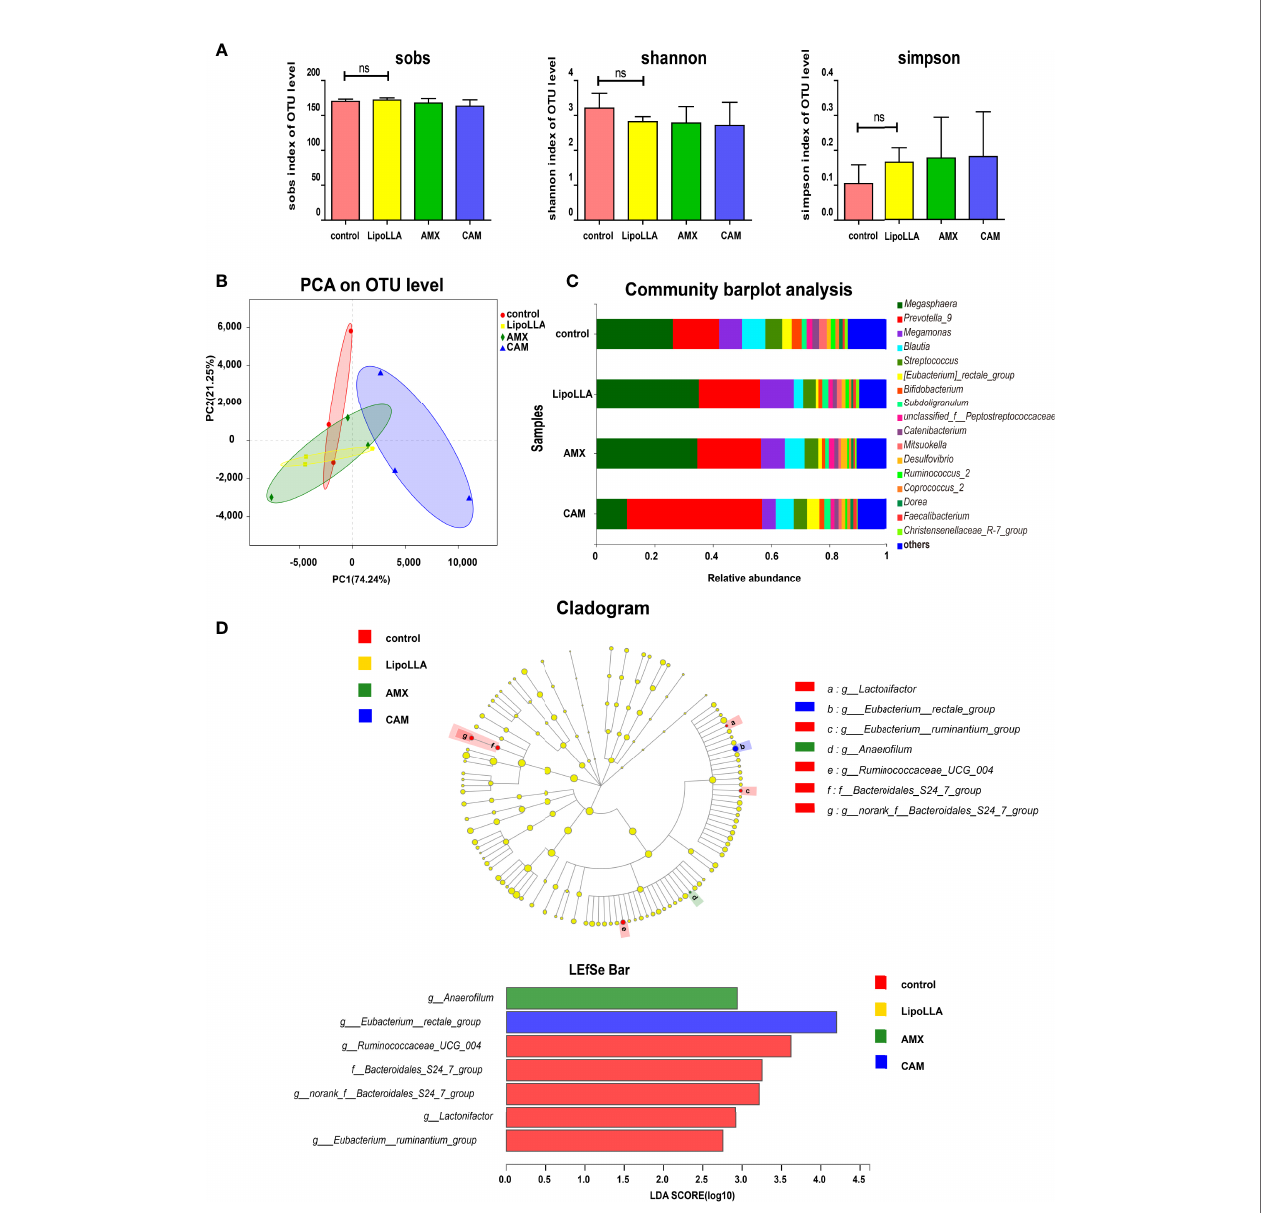
FIGURE 6 | Effect of LipoLLA on the human fecal fl ora. The alpha diversity indices of the fecal fl ora after four treatments (A) . PCA analysis was predicted to assess Beta diversity of the species after four treatments (B) . Analysis of community composition under genus level of four treatment groups (C) . The linear discrimination analysis coupled with effect size (LEfSe) analysis of four treatment groups, linear discriminant analysis (LDA analysis) showed the enrichment of different species in each group (D) . ns, no signi fi